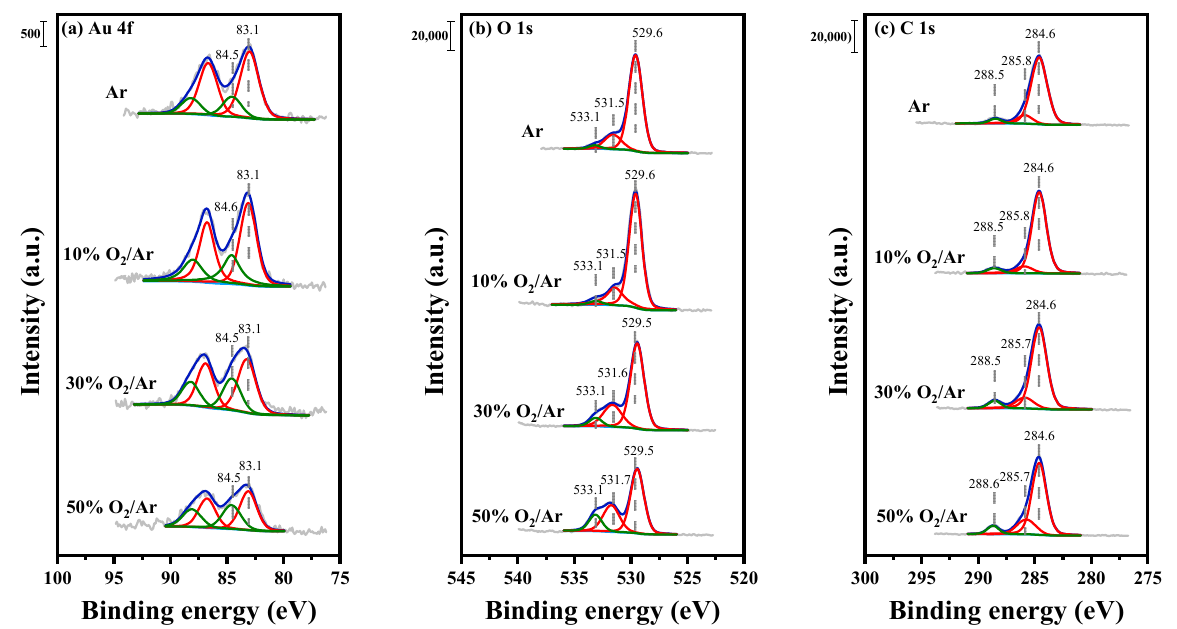
Figure 7. XPS spectra of the samples activated by plasmas at various O 2 contents in O 2 /Ar discharge gas: ( a ) Au 4f, ( b ) O 1s and ( c ) C 1s. Table 1. XPS analysis of the Au/TiO 2 samples. Proportion (at.%) Samples